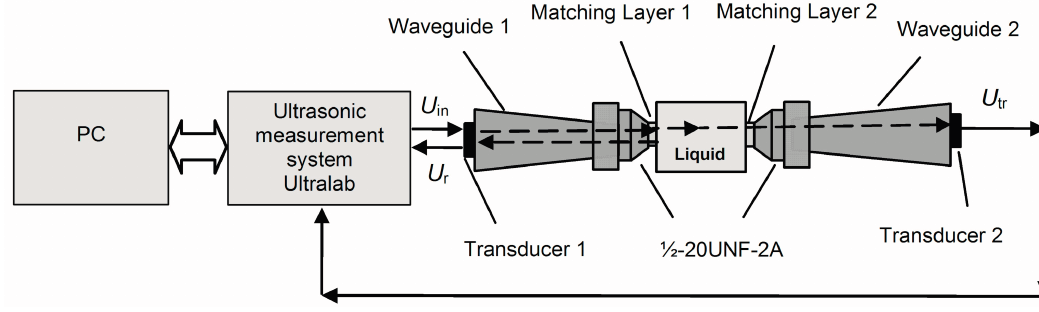
Figure 1. Ultrasonic density measurement